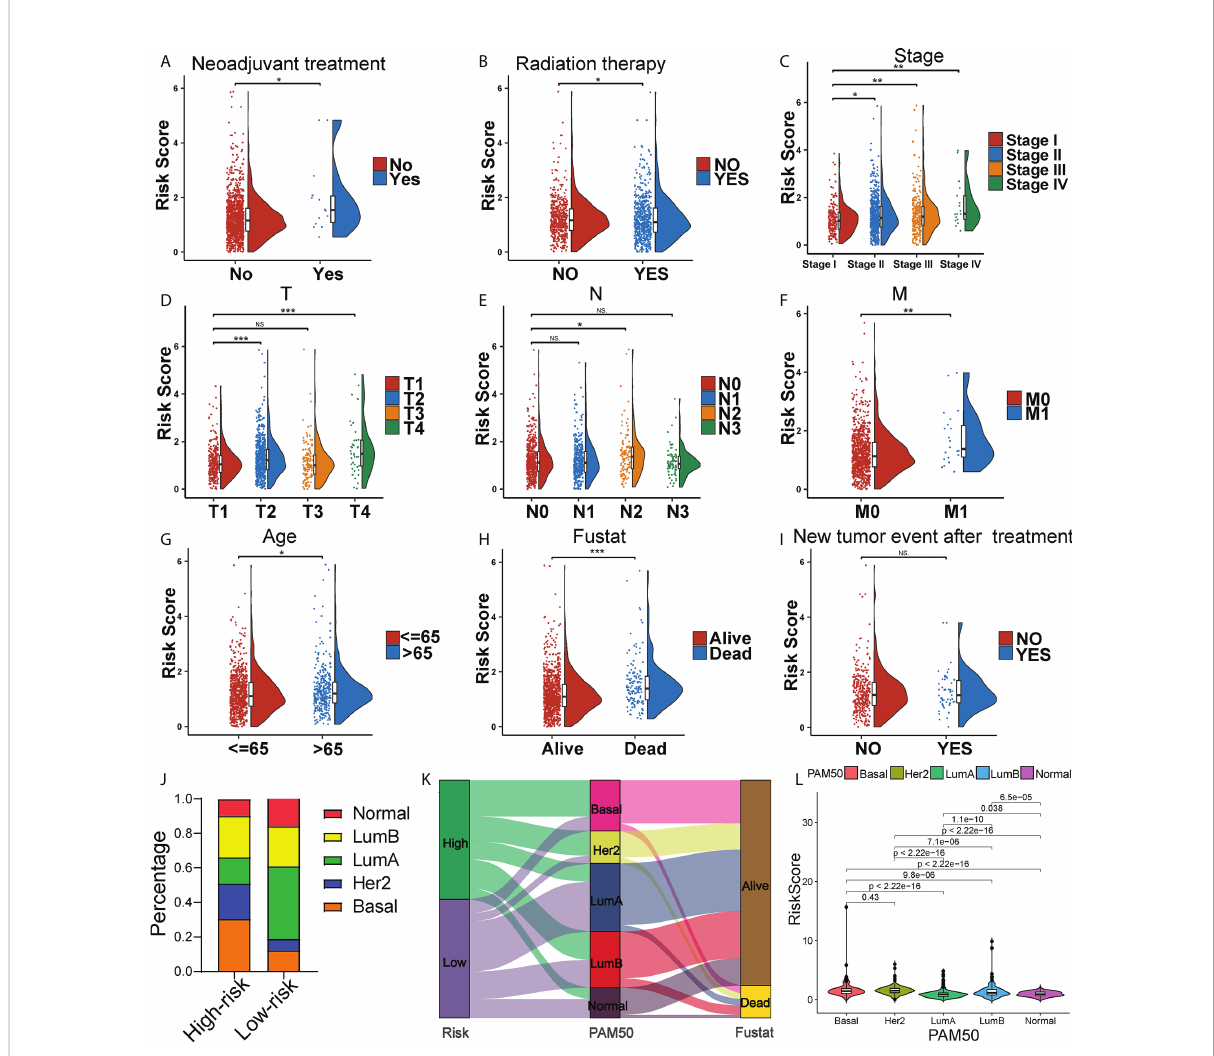
FIGURE 3 Clinical correlation of the risk score. The Raincloud plot showing the expression level of the risk score of the two risk group BC patients under neoadjuvant treatment (A) , and radiation therapy (B) , and in clinical stages (C) , T stages (D) , N stages (E) , M stages (F) , age groups (G) , death groups (H) , and new tumor event after treatment (I) . (J) The landscape of high- and low-risk-group patients at different BC subtypes. (K) Sankey diagram of distribution in subgroups with different risk scores, BC subtypes and survival states. (L) Box plots representing risk scores among all BC molecular subtypes. *P < 0.05, **P < 0.01; ***P < 0.001; ns, no signi fi